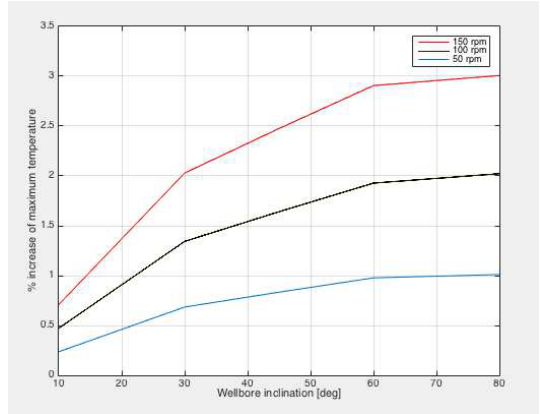
Figure 20: Increase in maximum temperature vs. inclination( µ = 0 .